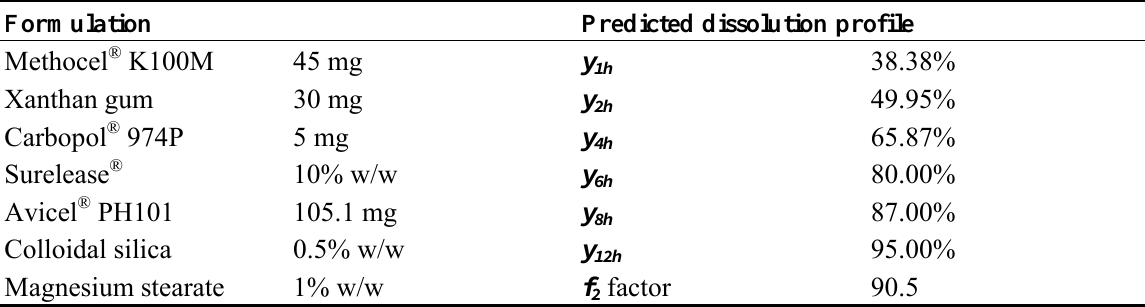
Table 3. Optimization